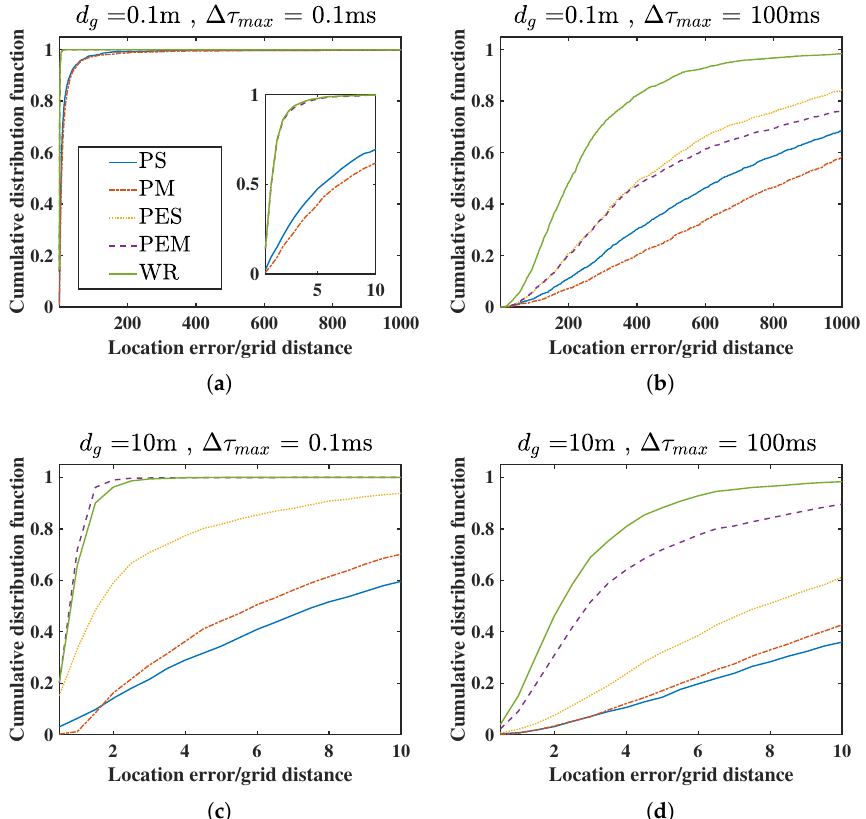
Figure 5. Simulation comparison in the cumulative distribution function (CDF) of relative distance error. ( a ) small steering time difference of arrival (TDOA) uncertainty and small grid distance (STSG); ( b ) large steering TDOA uncertainty and small grid distance (LTSG); ( c ) small steering TDOA uncertainty and large grid distance (STLG); ( d ) large steering TDOA uncertainty and large grid distance